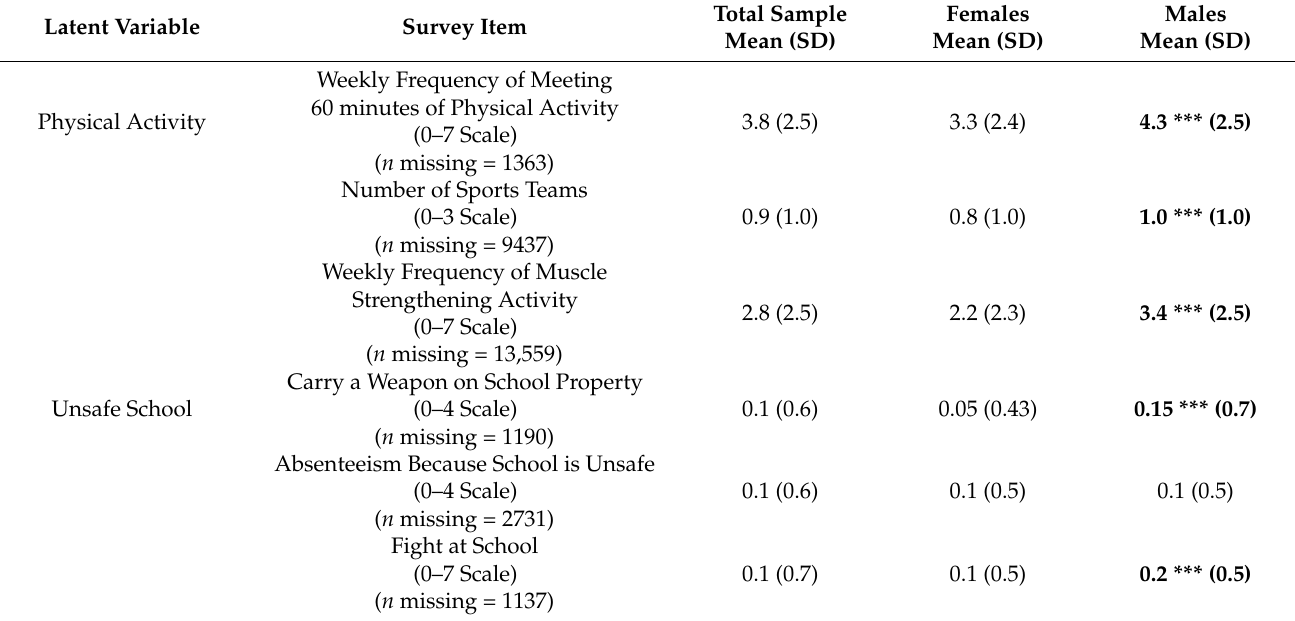
Table 2. Descriptive statistics for the total sample and within sex specific groups (presented as means and standard